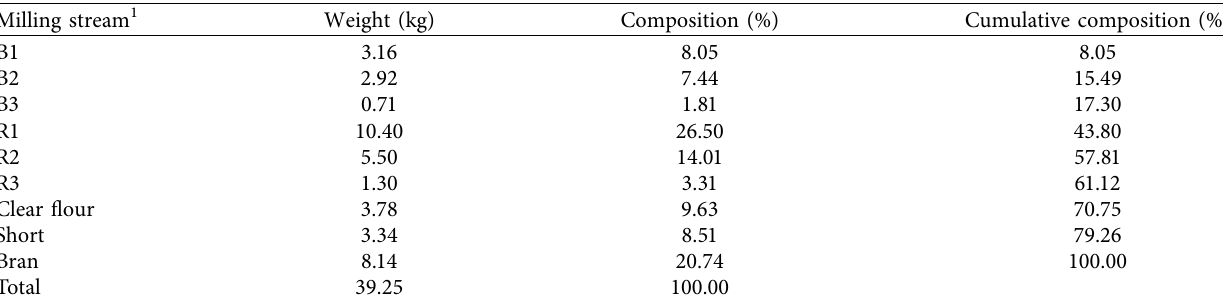
Table 1: Weights and compositions for individual flour stream of wheat (var. Jokyoung) by Buhler laboratory mill and composition. Milling stream 1